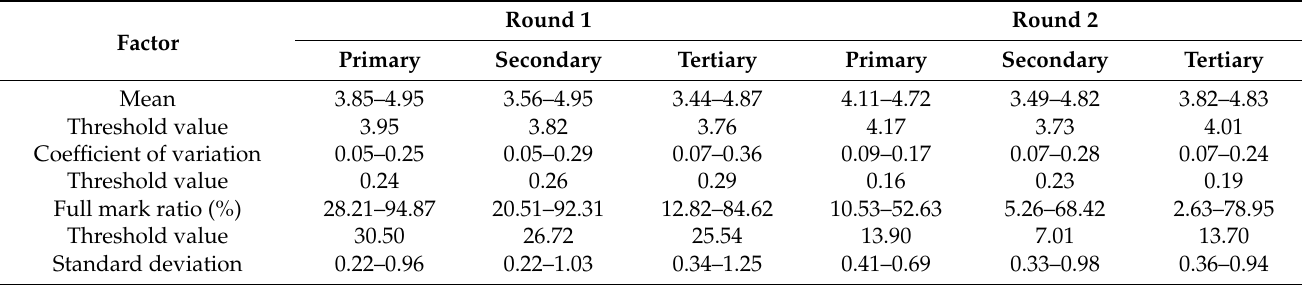
Table 3. Boundary values for the importance of all-level